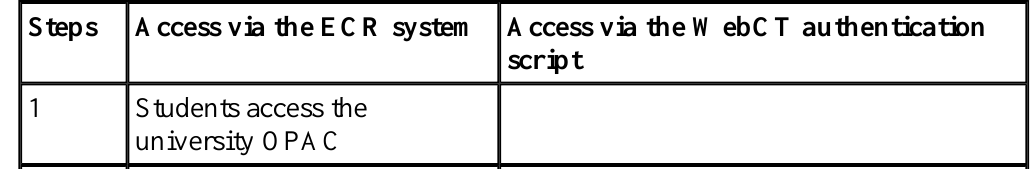
Table 1 Comparing two methods to access ECR